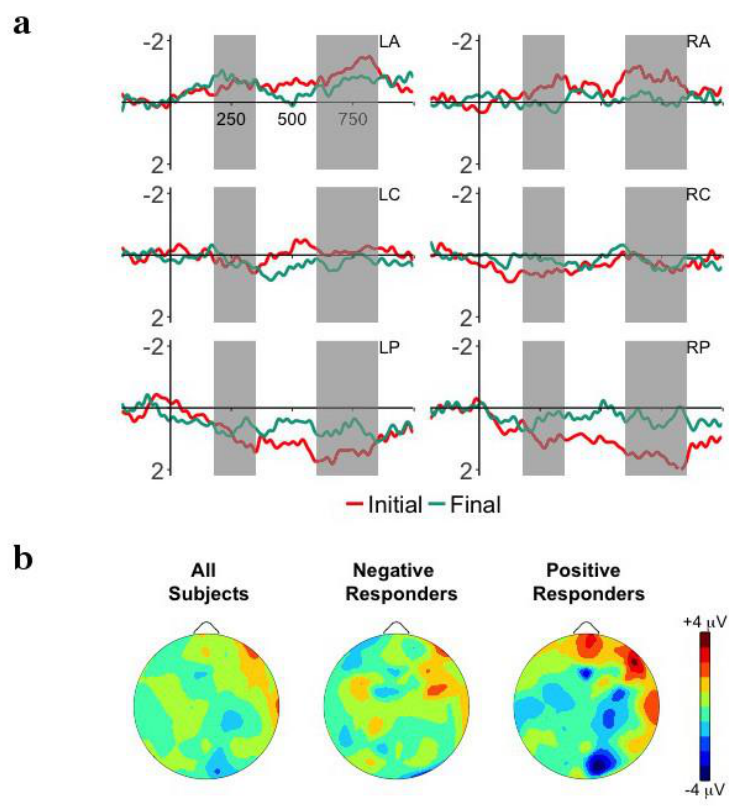
Figure 2. ( a ) Grand-average event-related potentials (ERP) responses time-locked to word onset for the first two (1st/2nd) and last two (7th/8th) tokens of the embedded target words in the Familiarization Phase for the 6 ROIs: left anterior (LA), right anterior (RA), left central (LC), right central (LR), left posterior (LP), right posterior (RP). The time windows of interest, 180–350 ms and 600–850 ms are highlighted in gray. ( b ) Mean distribution plots for the ERP effect of memory trace formation in the Familiarization Phase (7th/8th tokens—1st/2nd) in the 180–350 ms time window for overall group performance (left), Negative Responders (central), and Positive Responders (right).